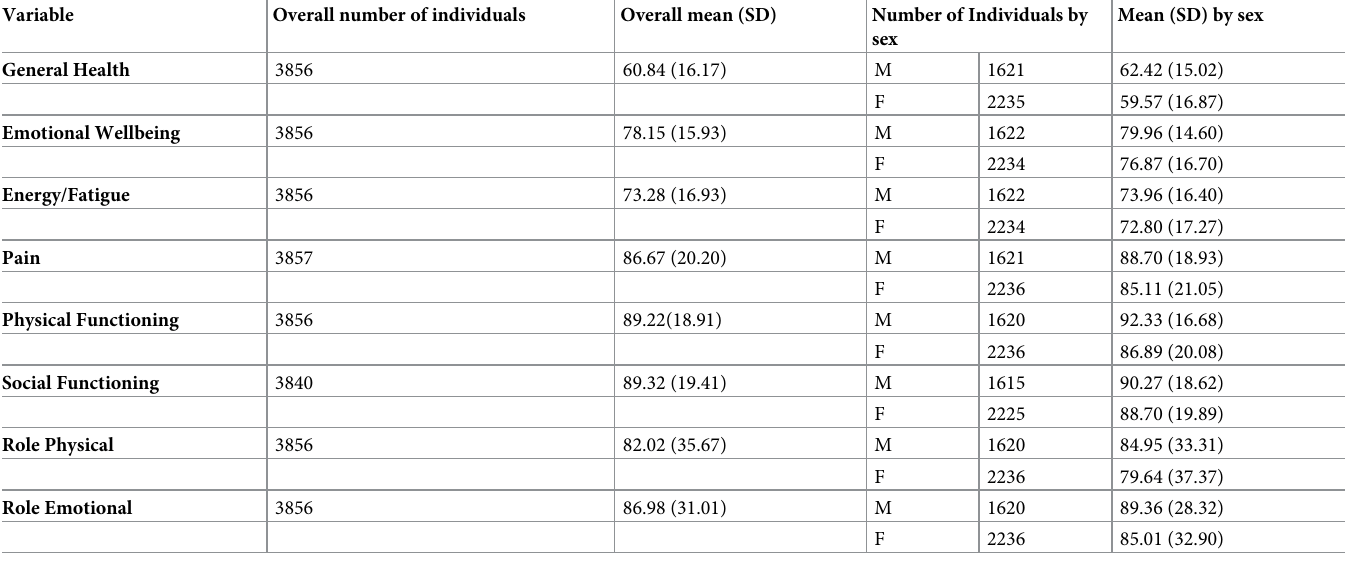
information on the sources of variance in the traits. For depressive symptoms, r MZ were greater than r DZ suggesting genetic effects ( A ). For the majority of the HRQL variables, the r MZ; r DZ was approximately 1:1 for both sexes, suggesting greater contribution of shared environment (C). For males, the r DZ for some variables were not significant, and the r MZ was Table 2. Mean (SD) scores of SF-36 scales overall and split by